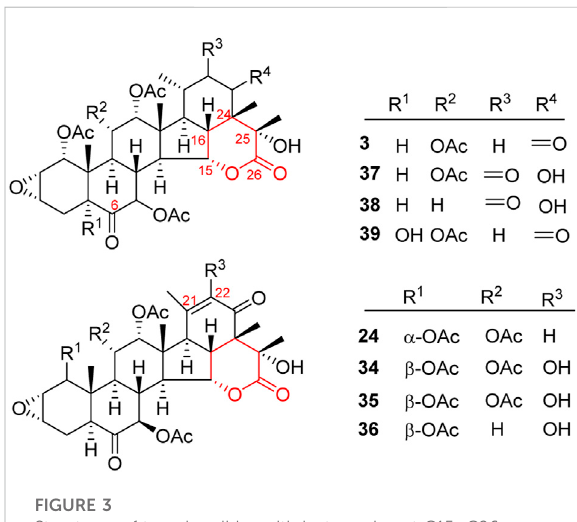
FIGURE 3 Structures of taccalonolides with lactone ring at C15 – C26.